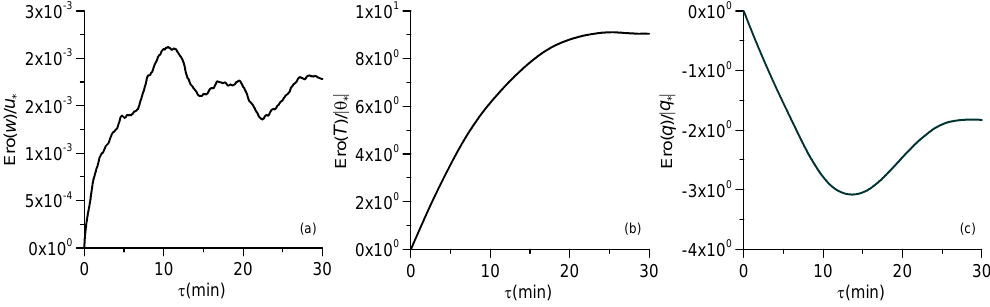
Figure 4. Variation of mean ergodic function Ero( w ) of the vertical velocity (a) , temperature (b) and specific humidity (c) before filtering